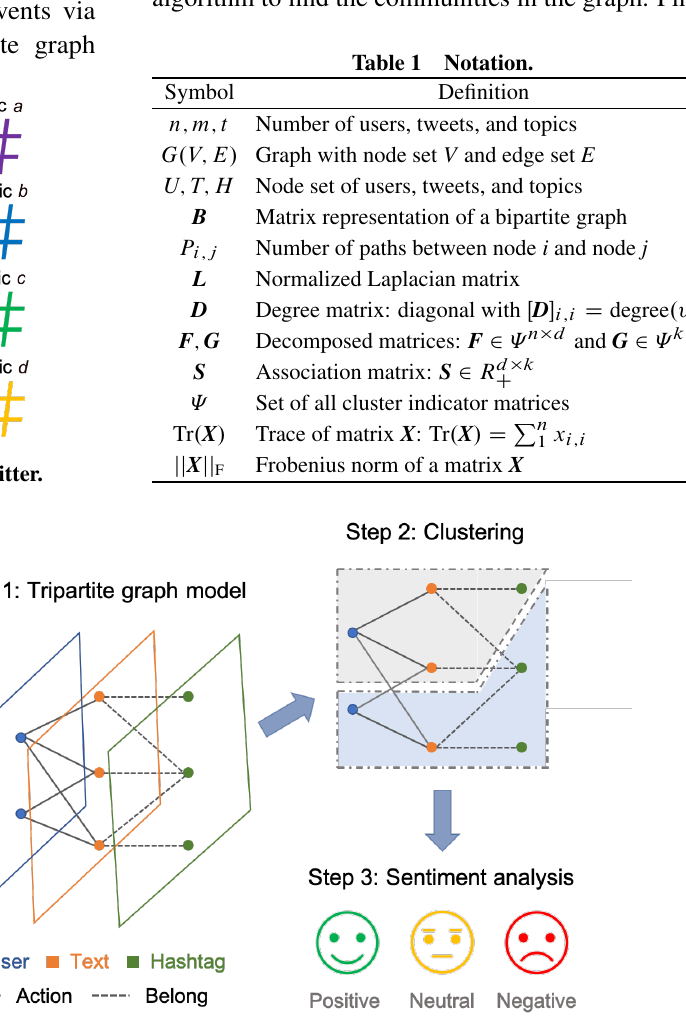
Fig. 4 An overview of the TGC-PDA